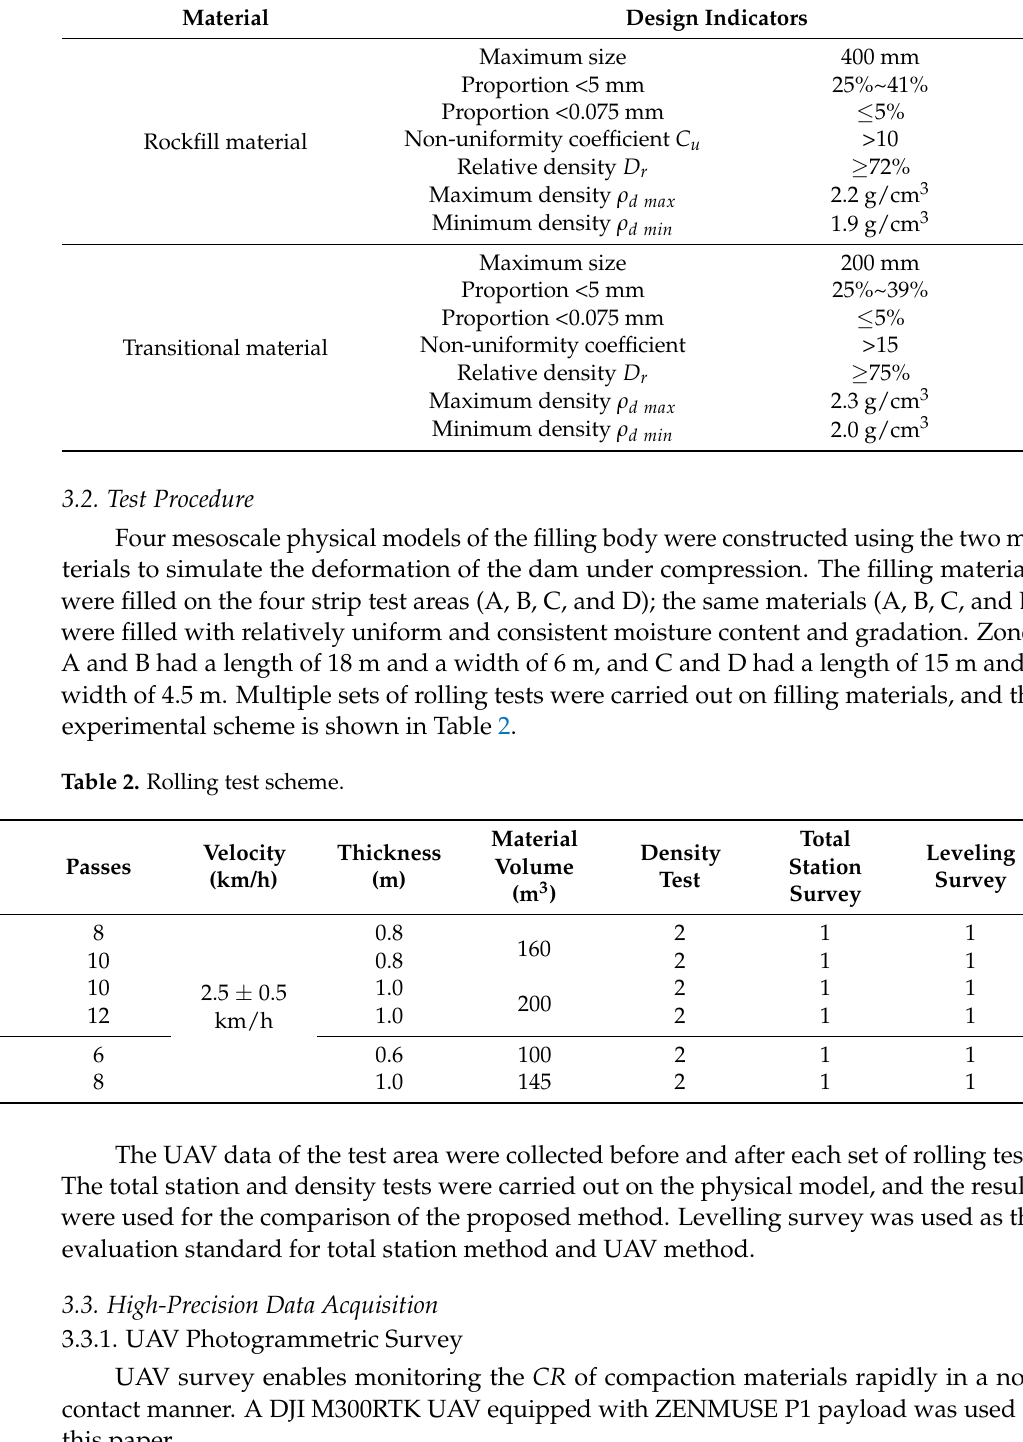
Table 1. Design indicators of the two materials.